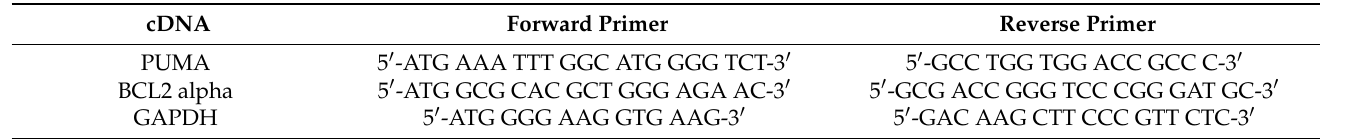
Table 2. Primer pairs for investigated genes: PUMA, BCL2 alpha, and GAPDH. cDNA Forward Primer Reverse Primer